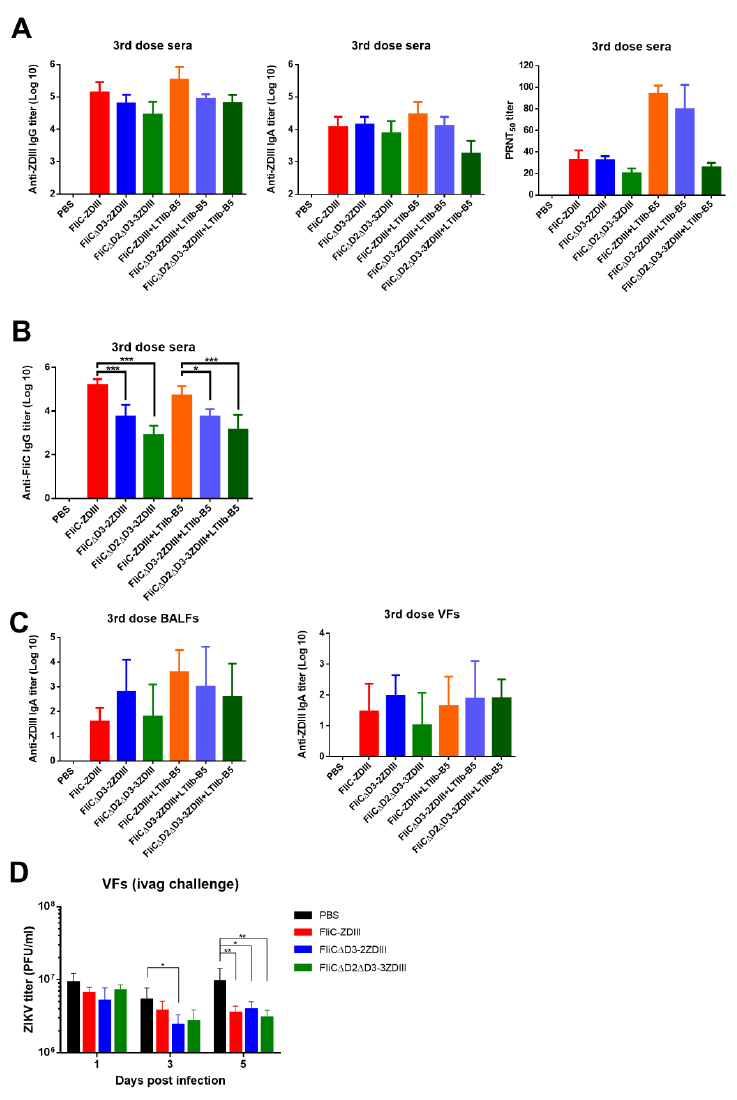
Figure 6. Immune responses elicited by the second ‐ generation FliC Δ D3 ‐ 2ZDIII and FliC Δ D2 Δ D3 ‐ 3ZDIII antigens. ( A ) Groups of BALB/c mice (n = 5 per group) were intranasally immunized with three doses of PBS, 40 μ g FliC ‐ ZDIII, 40 μ g FliC Δ D3 ‐ 2ZDIII, 40 μ g FliC Δ D2 Δ D3 ‐ 3ZDIII, 40 μ g FliC ‐ ZDIII + 3 μ g LTIIb ‐ B5, 40 μ g FliC Δ D3 ‐ 2ZDIII + 3 μ g LTIIb ‐ B5, and 40 μ g FliC Δ D2 Δ D3 ‐ 3ZDIII + 3 μ g LTIIb ‐ B5 in a three ‐ week interval. Sera and VFs were collected at week 8; BALFs at week 9. The ZDIII ‐ specific IgG, IgA and neutralizing antibody titers (PRNT ‐ 50) in sera, ( B ) Anti ‐ FliC ‐ specific IgG titers in sera, ( C ) ZDIII ‐ specific IgA in BALFs and VFs. ( D ) Additional groups were conducted at week 9 for the intravaginal (IVAG) challenge of 10 8 PFU of ZIKV. The virus titer in VFs was determined at day 1, 3 and 5 after the intravaginal (IVAG) challenge. Multiple group comparison for all groups not including the PBS ‐ immunized group for ( A – C ). Multiple group comparison was conducted for all groups at the specific day (day 1, 3 and 5). Data were analyzed using one ‐ way ANOVA with Tukey’s or Holm ‐ Sidak’s multiple comparison tests. (*, p < 0.05, **, p < 0.01, and ***, p < 0.001). Error bars are plotted as standard deviation from the mean value.